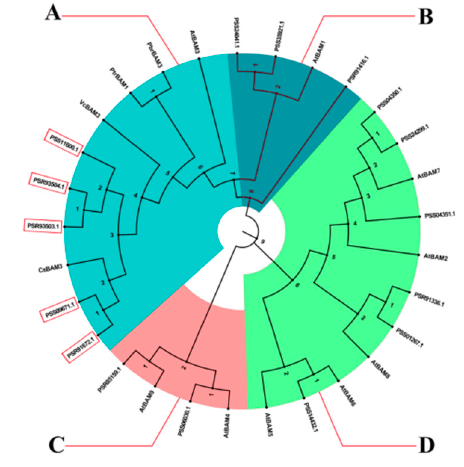
Figure 6. Phylogenetic trees of BAM genes in A. chinensis , Camellia sinensis , Citrus trifoliata , Vaccinium corymbosum , Pyrus bretschneideri, and A. thaliana based on maximum likelihood analysis of the BAM domain amino acid sequence alignment. Table 2. The basic information of the AcBAM gene family.